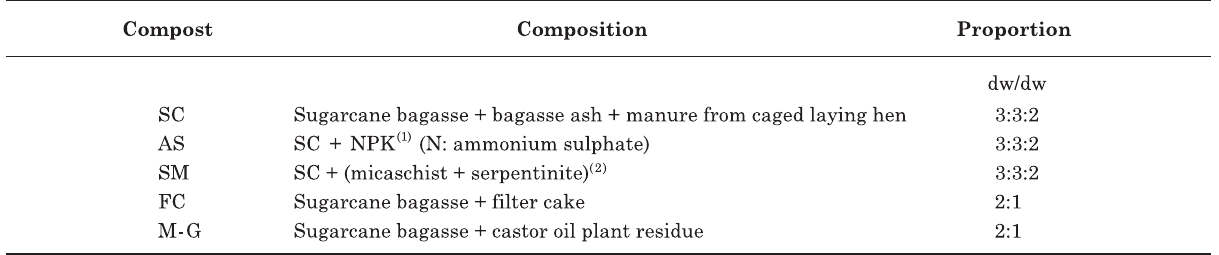
Table 1. Composts formulated with different materials and enriched with